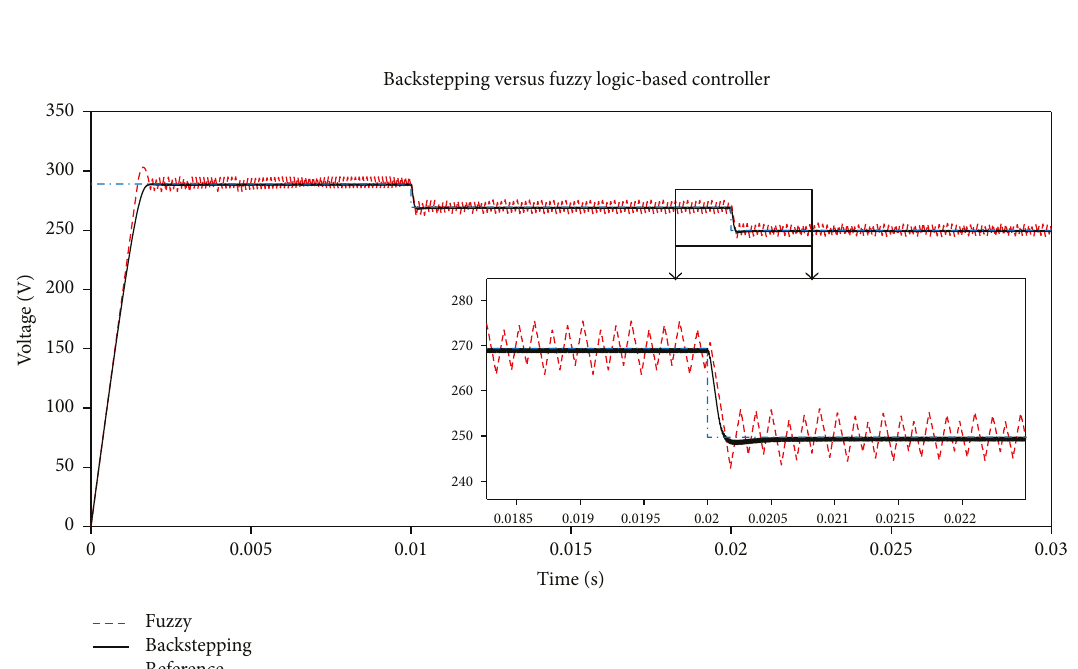
Figure 11: Power comparison under varying temperature.